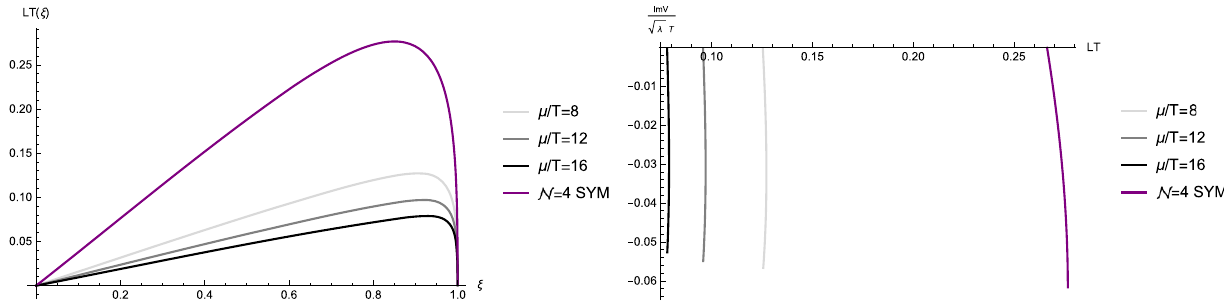
Fig. 3 Left: the plot of LT versus ξ in the different μ/ T at θ = 2 and z = 2 . 6. Right: ImV and z = 2 .